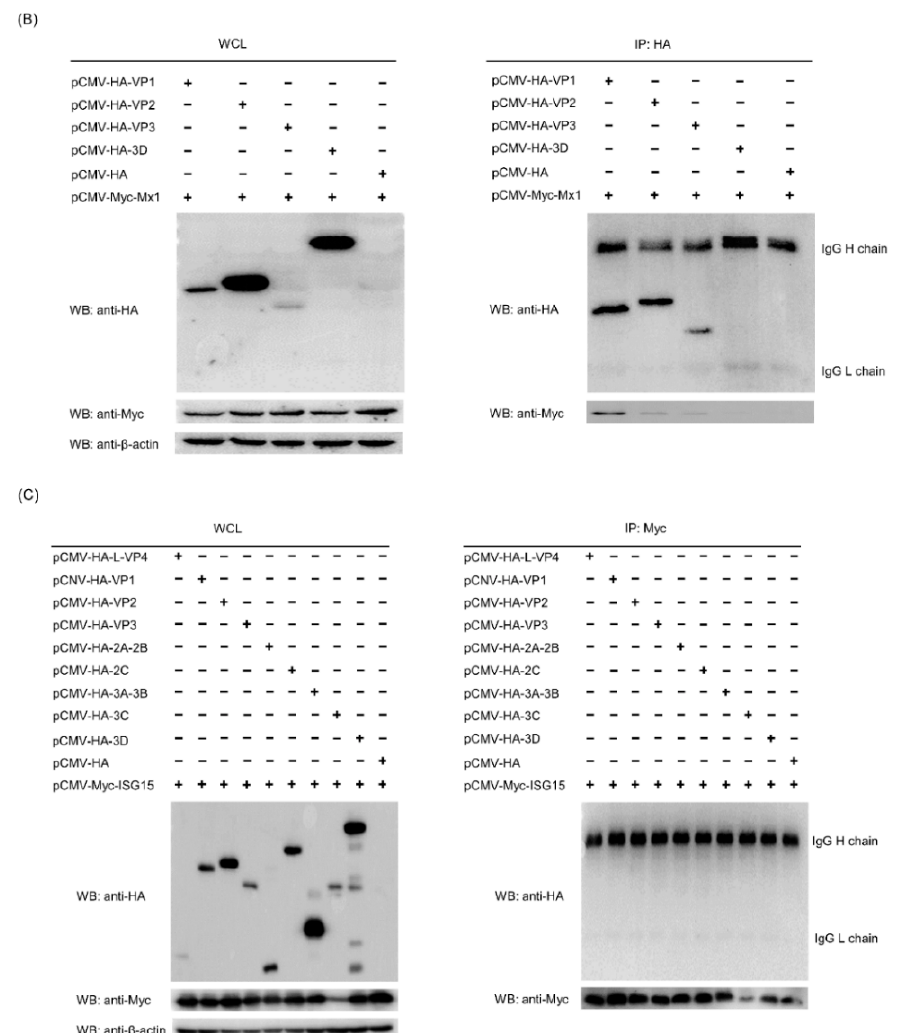
Figure 8. Mx1 but not ISG15 interacts with the VP1, VP2 and VP3 proteins of SVA. ( A , B ) WB and co-immunoprecipitation (Co-IP) analyses of HA-tagged SVA proteins and Myc-tagged Mx1 protein in co-transfected HEK293T cells. HEK293T cells were co-transfected with 1.25 µ g of pCMV-HA-L-VP4, pCMV-HA-VP1, pCMV-HA-VP2, pCMV-HA-VP3, pCMV-HA-2A-2B, pCMV-HA-2C, pCMV-HA- 3A-3B, pCMV-HA-3C, pCMV-HA-3D or pCMV-HA, and 1.25 µ g of pCMV-Myc-Mx1. At 36 hpt, the cells were harvested to prepare whole cell lysates (WCL) for WB and Co-IP analyses using mouse anti-Myc and -HA mAbs. ( C ) WB and Co-IP analyses of HA-tagged SVA proteins and Myc-tagged ISG15 protein in co-transfected HEK293T cells. The cells were co-transfected, harvested, processed and analyzed as in ( A ), but with a different plasmid pCMV-Myc-ISG15. 3.10. Mx1-Associated GTPase, Oligomerization and Interaction Activities Are Required for